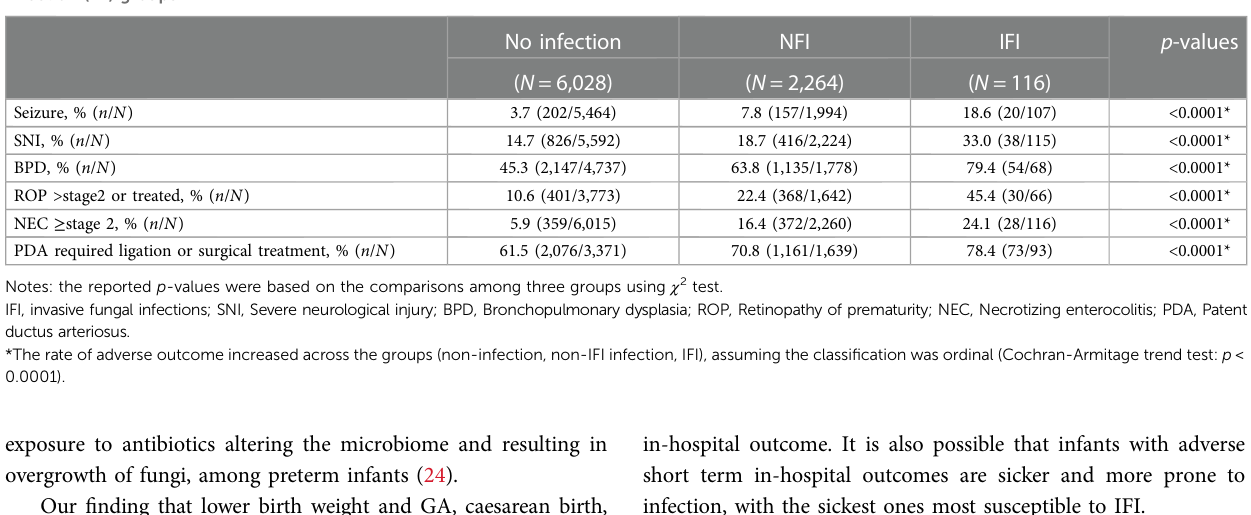
TABLE 5 Comparison of short-neonatal outcomes among infants with no infection, infection without invasive fungal infection (NI) and invasive fungal infection (IFI)